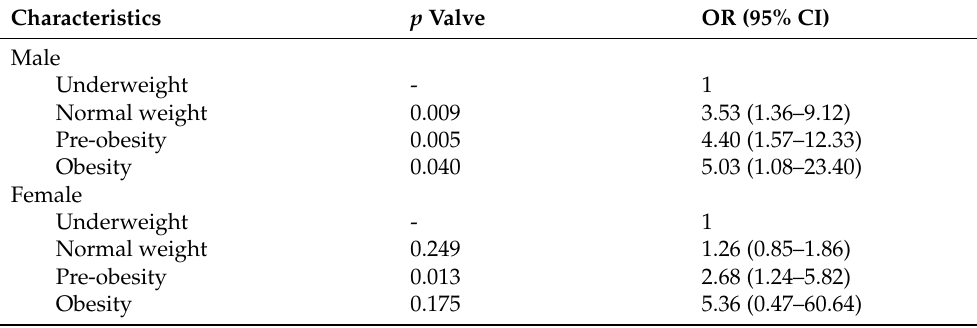
Table 2. Results of univariate logistic regression analysis for the association between anxiety and